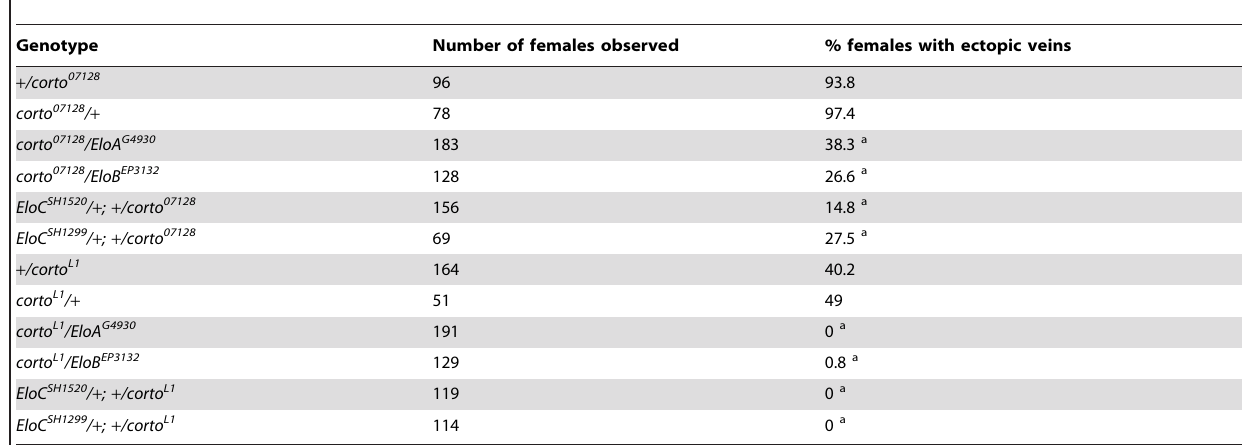
Table 3. Decreasing EloA, EloB or EloC expression partially suppresses ectopic veins induced by corto loss-of-function.